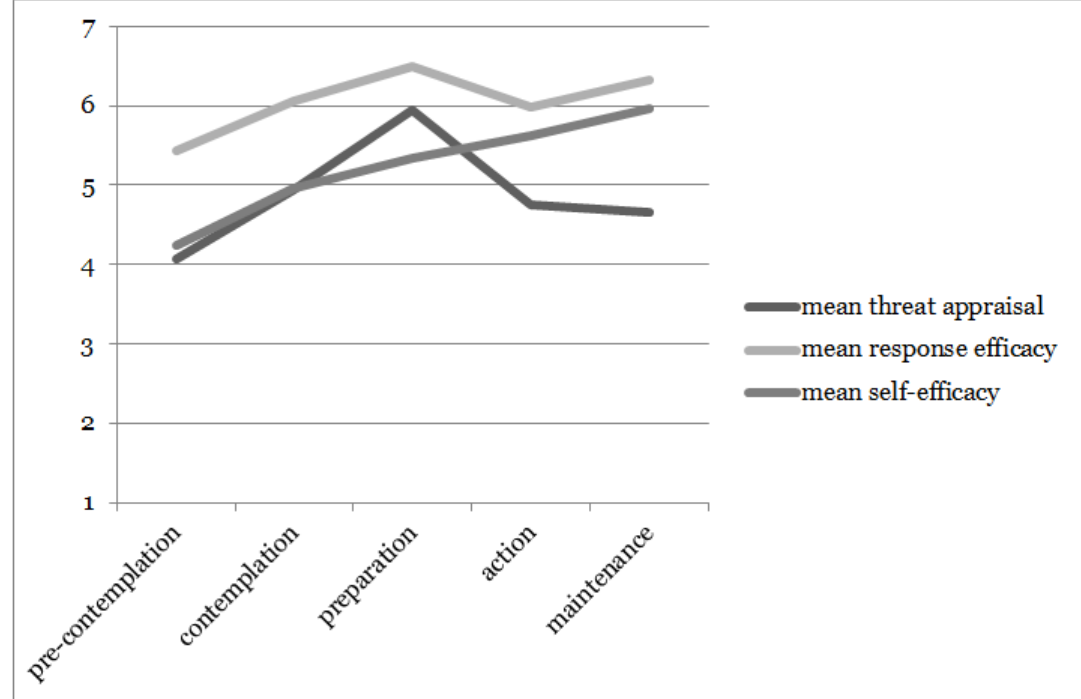
Figure 3. Threat appraisal, response efficacy and self-efficacy across the